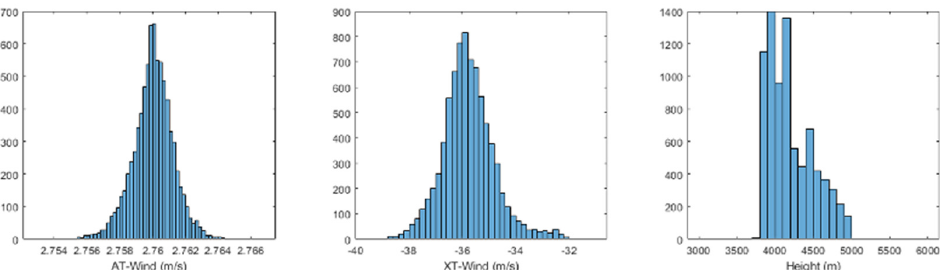
Figure 19. Histograms show the wind retrievals passing the quality criteria. The AT winds are very close to the prior value used. close to the prior value